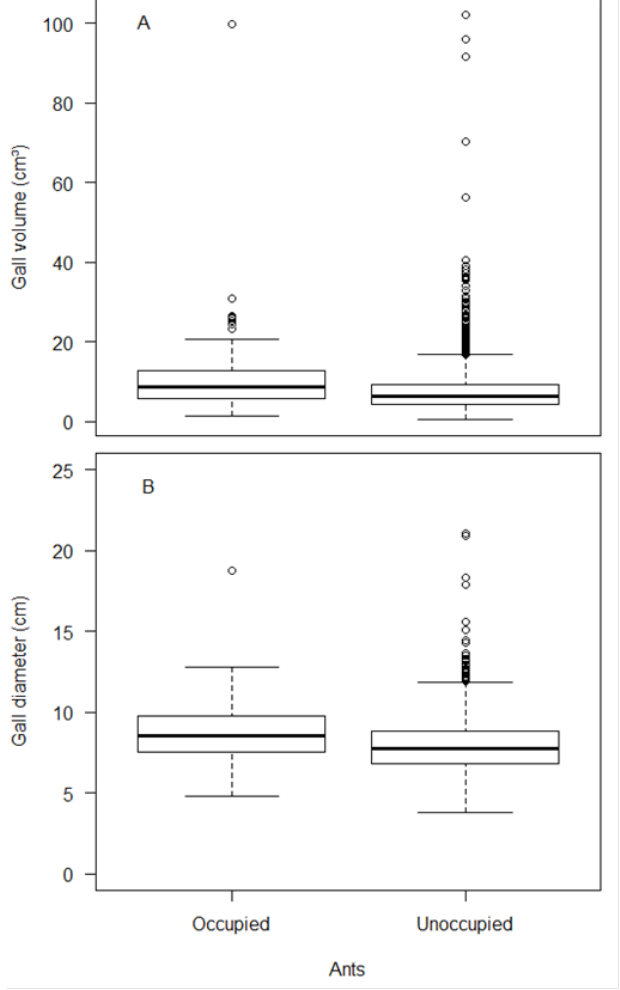
Fig 3 . Size (volume and diameter) of senescent stem galls on candeia trees Eremanthus erythropappus (DC.) MacLeisch (Asteraceae). The volume (w = 342.370; p = 0.001; A) and the diameter (w = 336.890, p < 0.001; B) of occupied galls were higher than those of galls not occupied by ants.